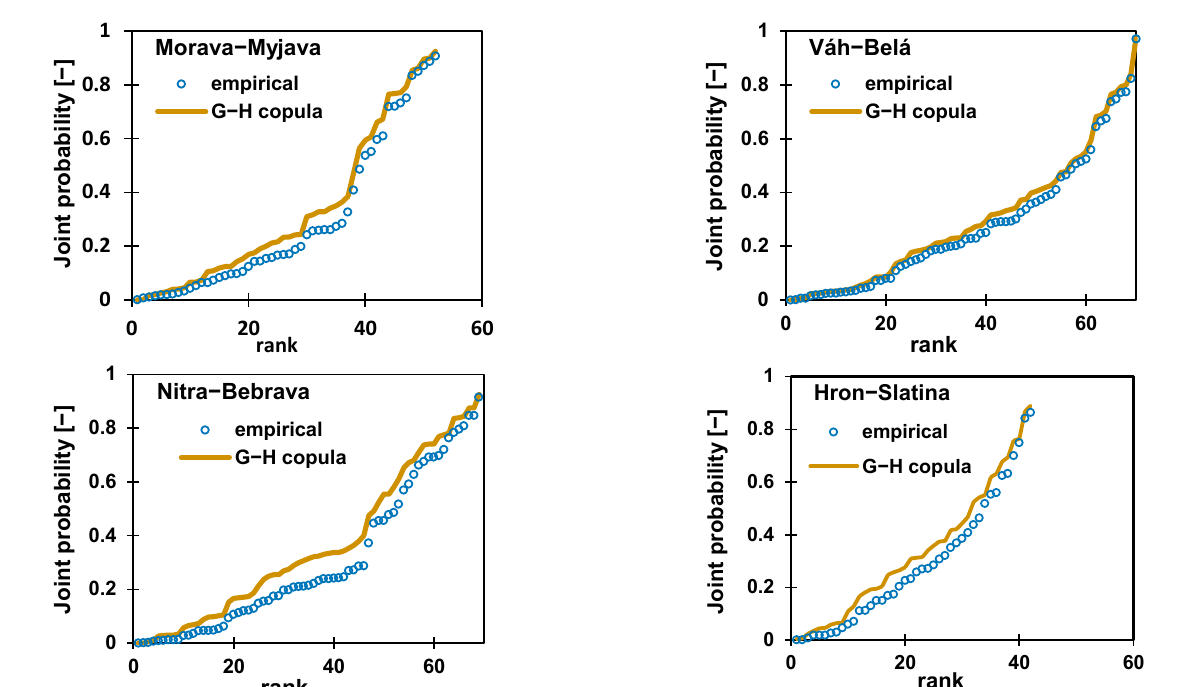
Figure 6. The joint empirical probability (points) and Gumbel–Hougaard copula at selected rivers and their tributaries (Q maxup − Q maxtr ).